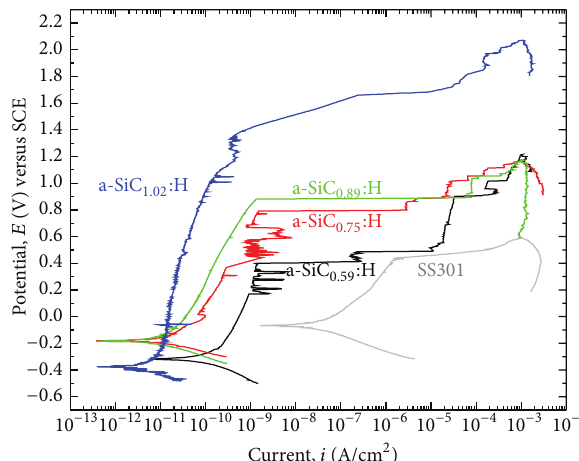
Figure 5: Potentiodynamic polarization curves of a-SiC